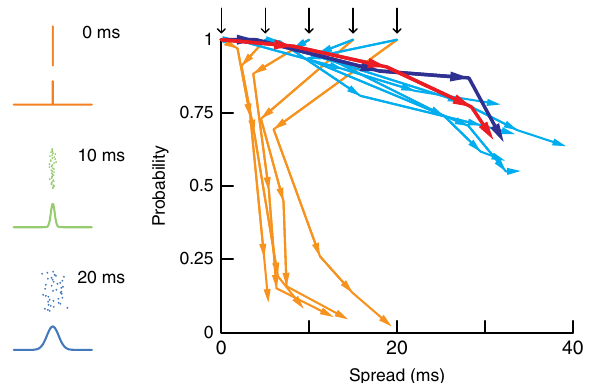
Fig. 3 Phase diagram of spike propagation. Plot of spike probability vs spike spread for different initial conditions in sparse (orange) and in dense (cyan) networks. The jitter in the light pulse stimuli (pulse packet) delivered to the neurons was varied (left, examples of Gaussian distributed pulse packets with standard deviations of 0, 10, and 20 ms widths). Black arrows indicate stimulus jitters and arrowheads connected by lines indicate values in successive layers (from 1 to 4). Data are compiled from n = 15 sparse and n = 16 dense networks and are from the same networks in Fig. 2. Red and dark blue lines denote trajectories in sparse and dense networks, respectively, where all neurons in the fi eld of view were activated synchronously (17 sparse networks of density = 303 ± 59 neurons·mm − 2 and 14 dense networks of density = 569 ± 80 neurons·mm − 2